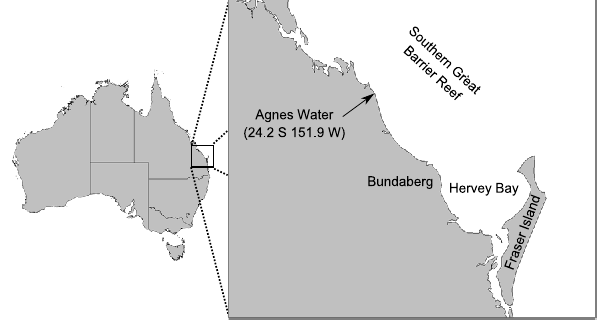
Fig. 1. Map of Australia detailing the sampling point (Agnes Water) and